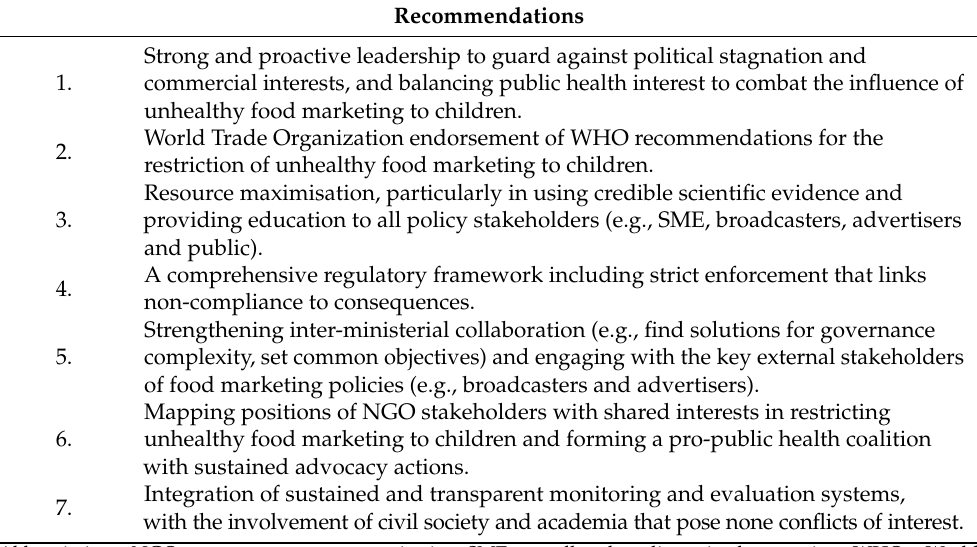
Table 2. Recommendations for stakeholders to progress food marketing policy